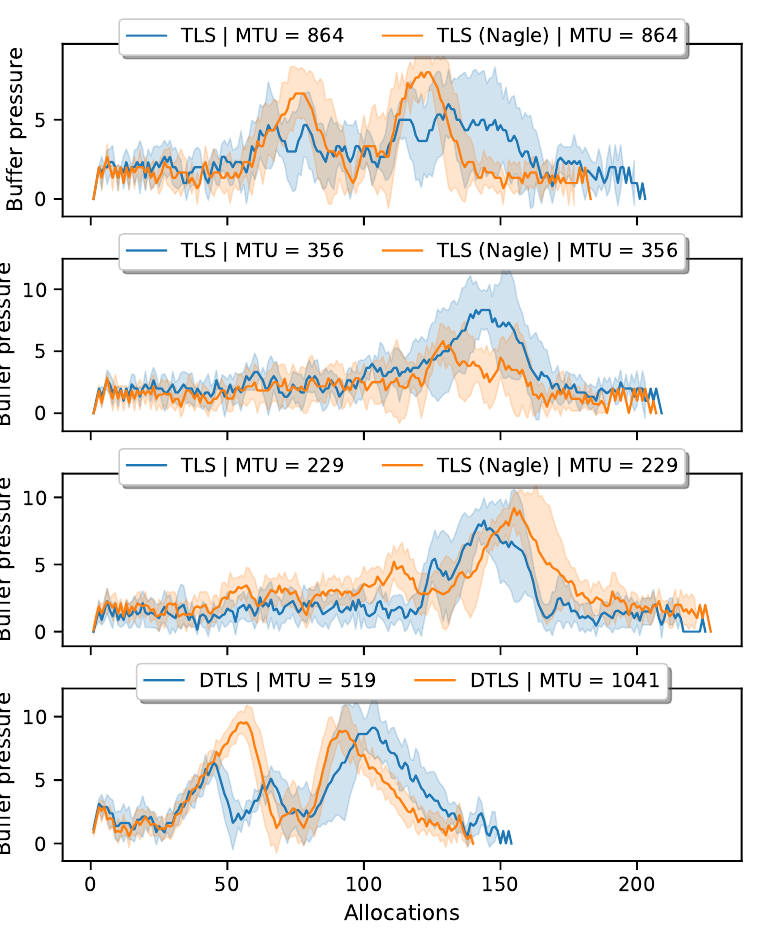
Figure 10. Measured buffer pressure on the constrained endpoint for different network configurations. The y-axis shows the number of packets in the queue. The x-axis shows the number of calls to the packet allocation function in